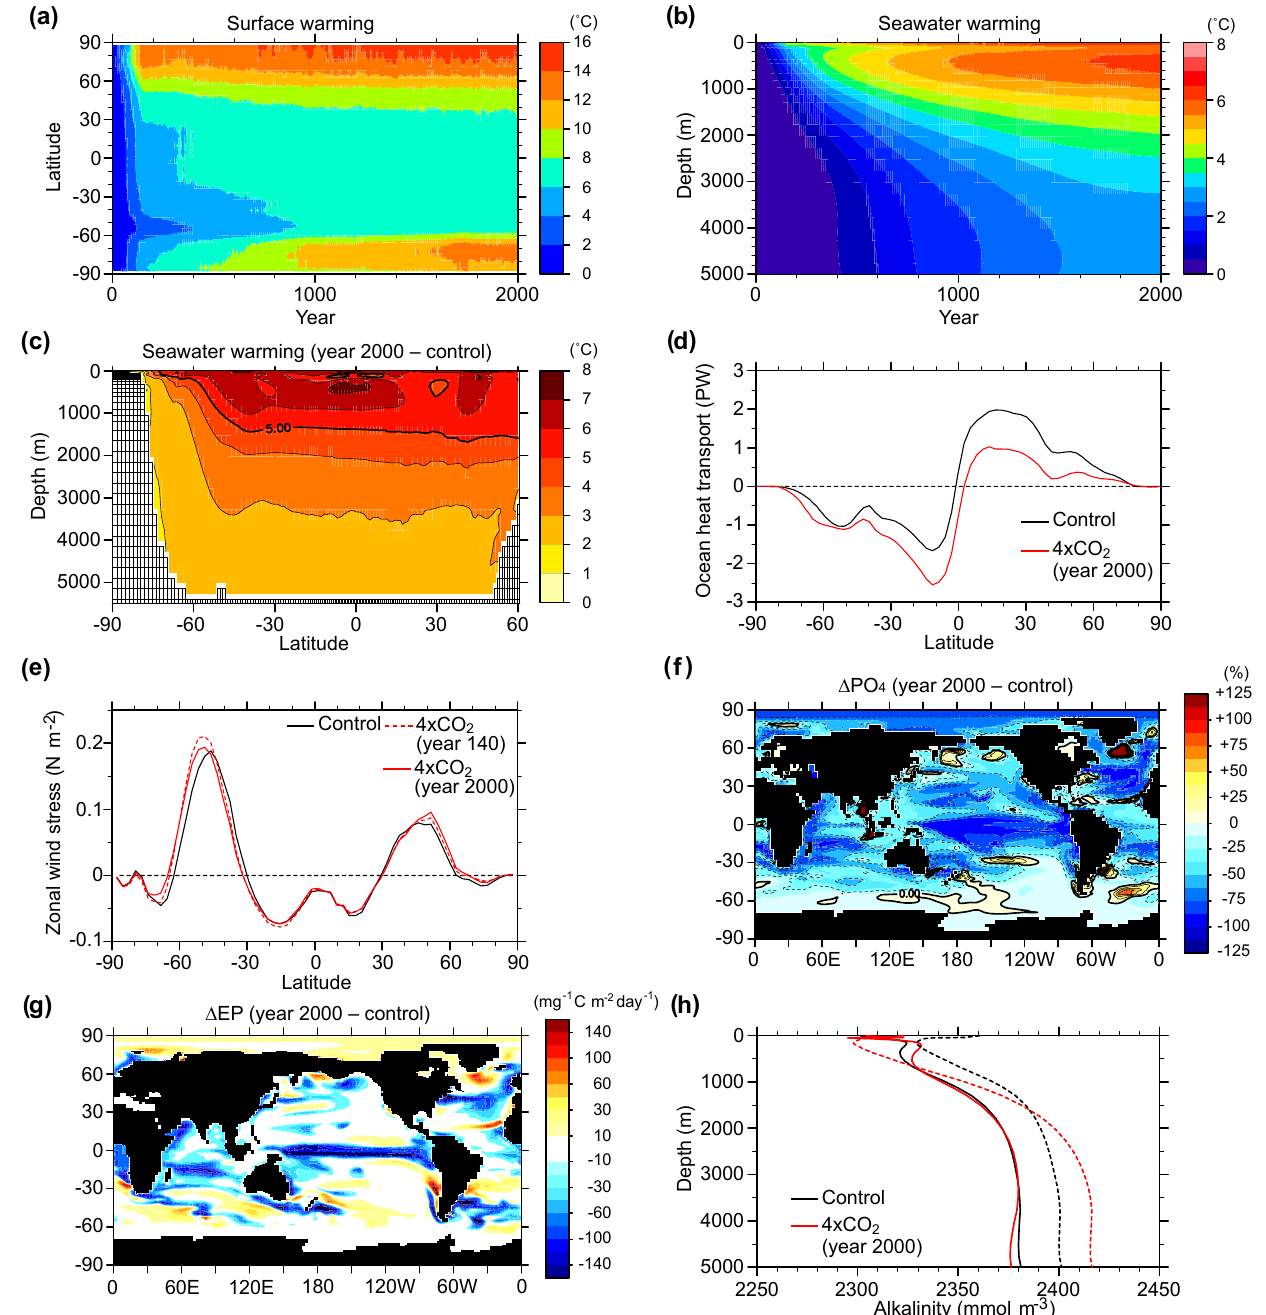
Figure 2. Changes in the physical and biological variables in the global warming experiment. Hovmöller diagrams of (a) the zonally averaged anomaly of the surface temperature and (b) the horizontally averaged anomaly of the seawater temperature. (c) Zonal mean changes in the seawater temperature between the control run and the end of the global warming experiment (year 2000). (d) Northward ocean heat transport for the control (black) and the end of the global warming runs (red). (e) Zonal mean wind stress for the control run (black) and at the time of CO 2 quadrupling (years 140 and 2000: red dashed and solid lines, respectively). Changes in (f) the surface PO 4 (averaged over the top 50m) and (g) the export production at the end of the global warming run. (h) Vertical profile of the alkalinity (solid lines) and salinity-normalized alkalinity (dashed lines) for the control (black) and global warming (red)